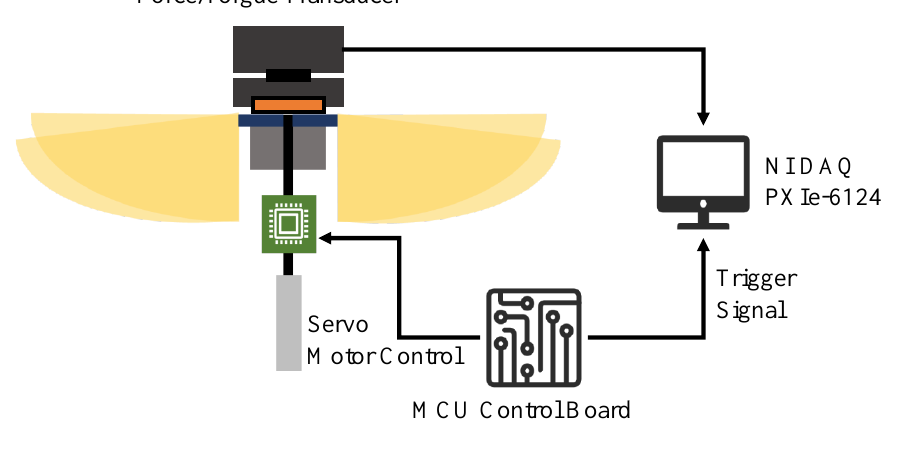
Figure 4. Illustration of force and torque test.